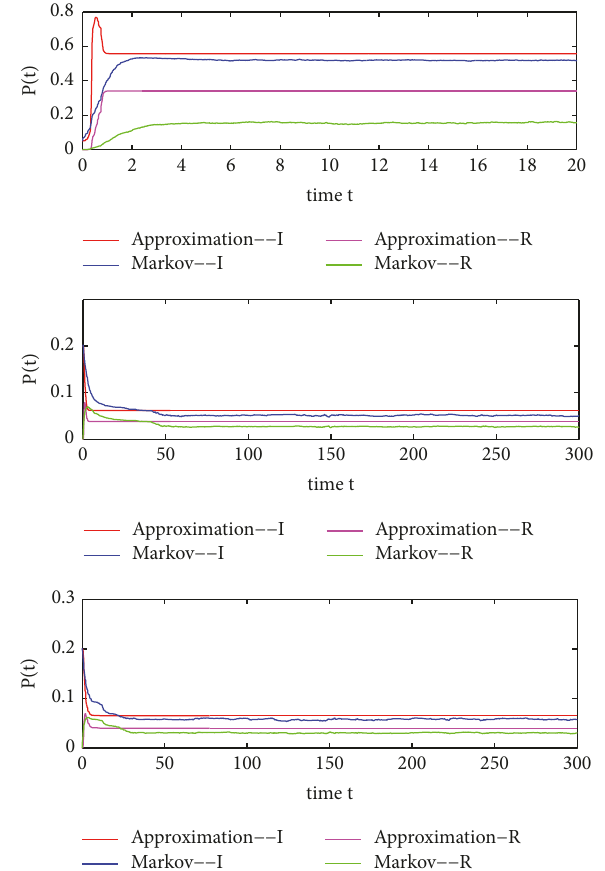
Figure 8: Comparison of results between two models for fully connectednetworks (Top), NWsmall-world networks (Middle) and BA scale-free networks